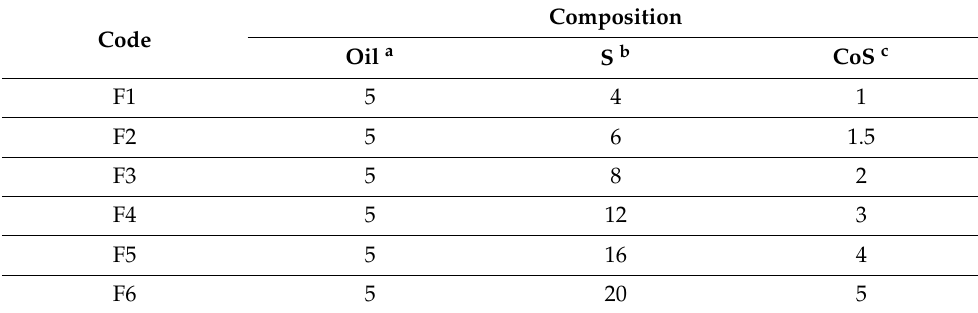
Table 1. Composition of TDL loaded L-SNEDDS